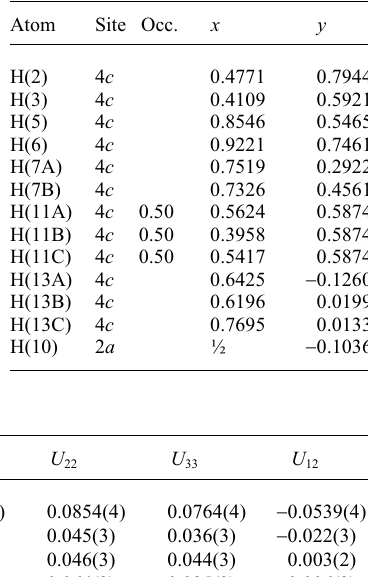
Table 2. Atomic coordinates and displacement parameters (in Å 2 ) .